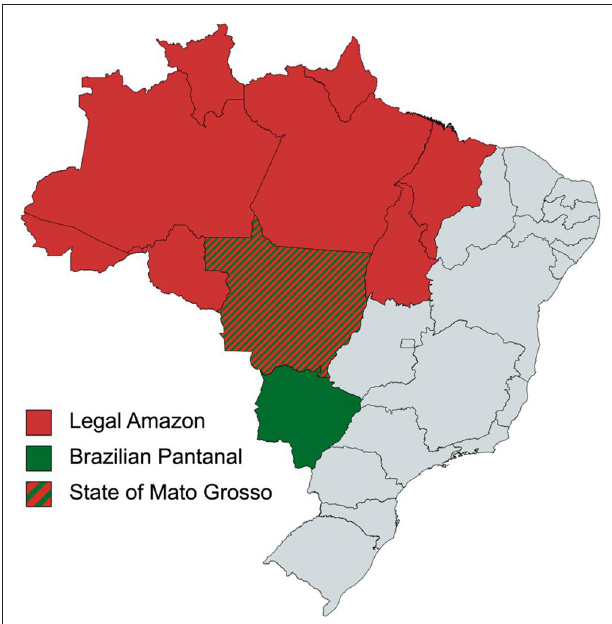
FIGURE 1 | The map of Brazil showing the extents of the Legal Amazon and the Pantanal. The state of Mato Grosso includes 35% of the Brazilian Pantanal and the state of Mato Grosso do Sul includes the remaining 65%. The northern parts of the state of Mato Grosso include areas of Legal